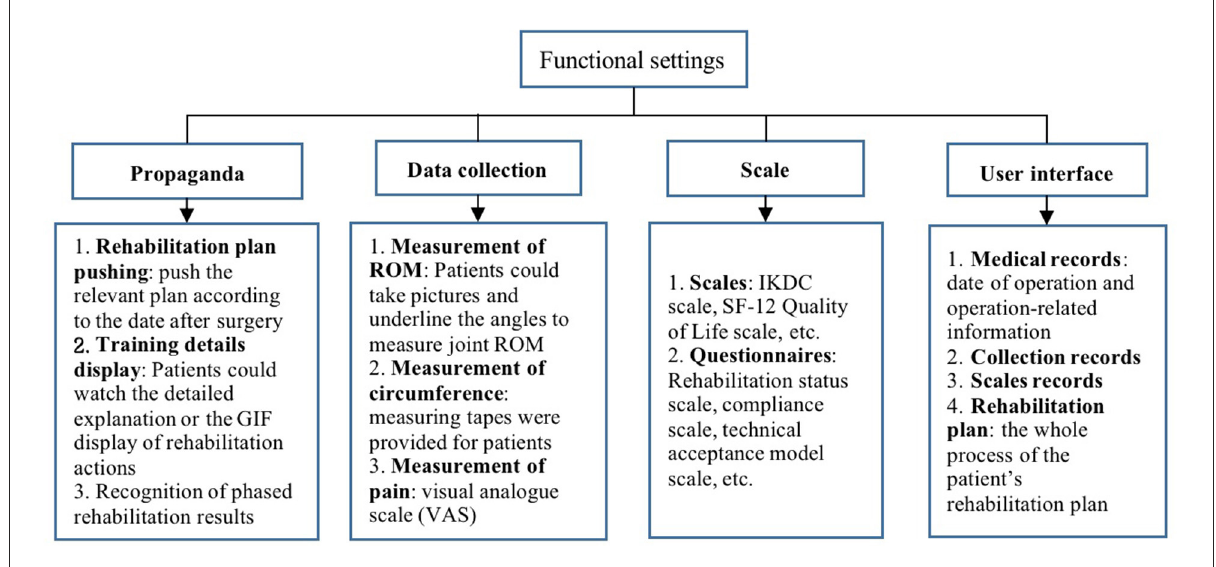
FIGURE1 Function settings of the “Rhabilitation Cloud Platform.” The figure shows the four functions of the “Rhabilitation Cloud Platform” and their detailed introduction.